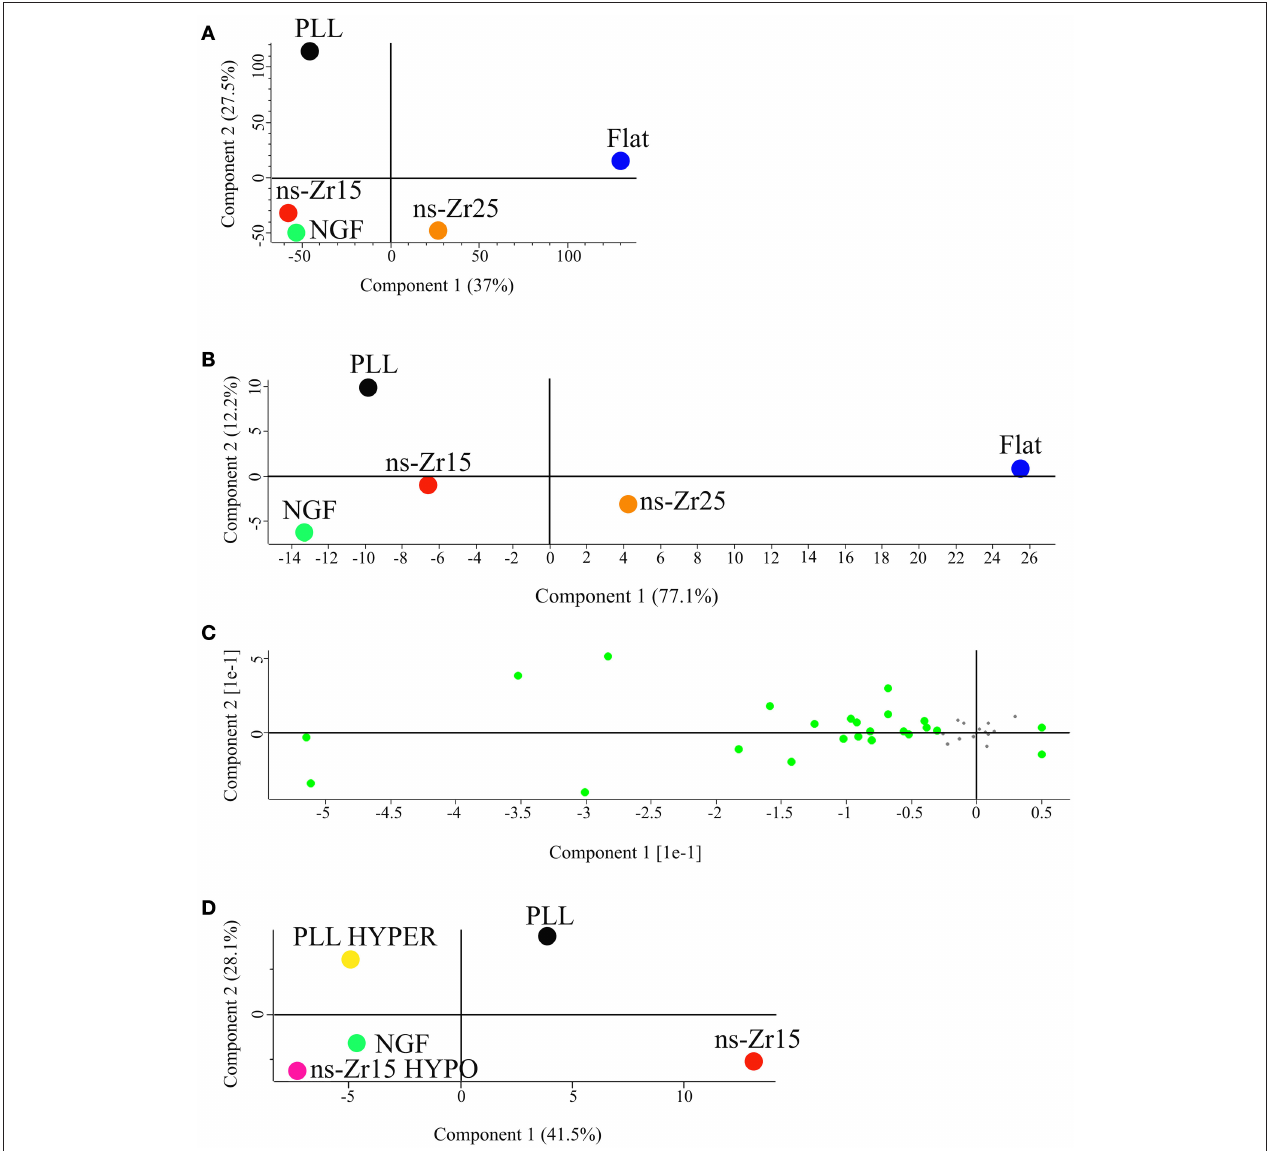
FIGURE 3 | Principal component analysis (PCA) on the phosphoproteome of PC12 cells grown in different experimental conditions. (A) PCA analysis of the phosphopeptides of PC12 cells in the experimental conditions PLL, NGF, ns-Zr15, ns-Zr25, and flat-Zr. (B) PCA analysis of the sequence phospho-motifs present in the phosphoproteome data of PLL, NGF, ns-Zr15, ns-Zr25, and flat-Zr. (C) Visual representation of the PCA analysis of the sequence phospho-motifs. All the substrate motifs that are more relevant in the PCA analysis are marked in green. (D) PCA analysis of the phosphopeptides of PC12 cells in the experimental conditions PLL, NGF, ns-Zr15, PLL hyper, and ns-Zr15